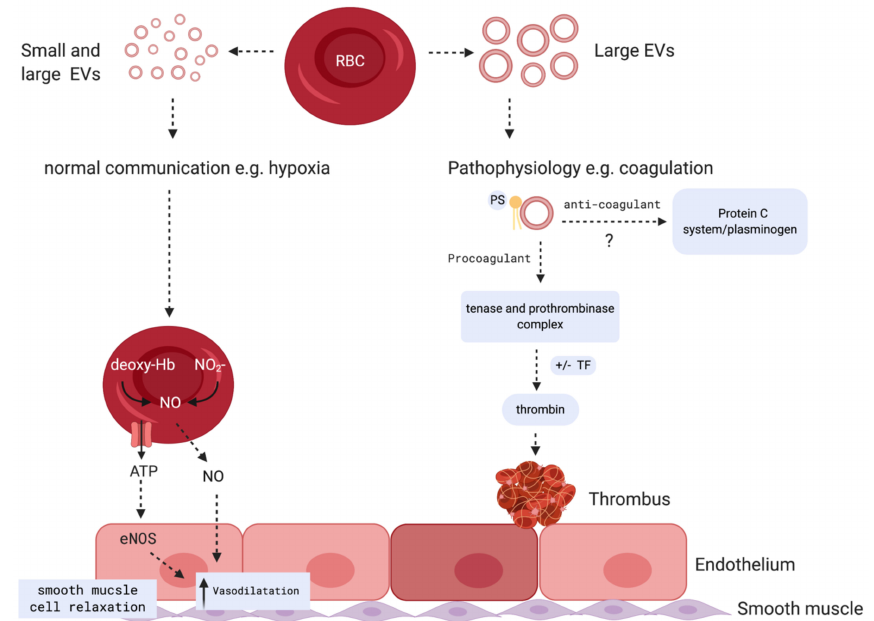
Figure 4. Potential biological role of RBCEVs: During hypoxia, small and large RBC vesicles carry factors that are responsible for NO production mediated by eNOS, resulting in an increase in vasodilation and smooth muscle cell relaxation (left panel). Large RBC vesicles are reported to play both pro and potential anti-coagulant roles (right panel): MVs mediate procoagulant activities by facilitating assembly of tenase and prothrombinase complexes on phosphatidylserine and promoting thrombin generation. Potential ability of MVs to mediate anticoagulant reactions through their interactions with protein S and activation of anticoagulant protein C system and plasminogen on their surface was reported. This process, in some circumstances, may create an anti-inflammatory and anti-coagulant response based on EV release from certain cells including neutrophils and platelets [116]. (Figure created with